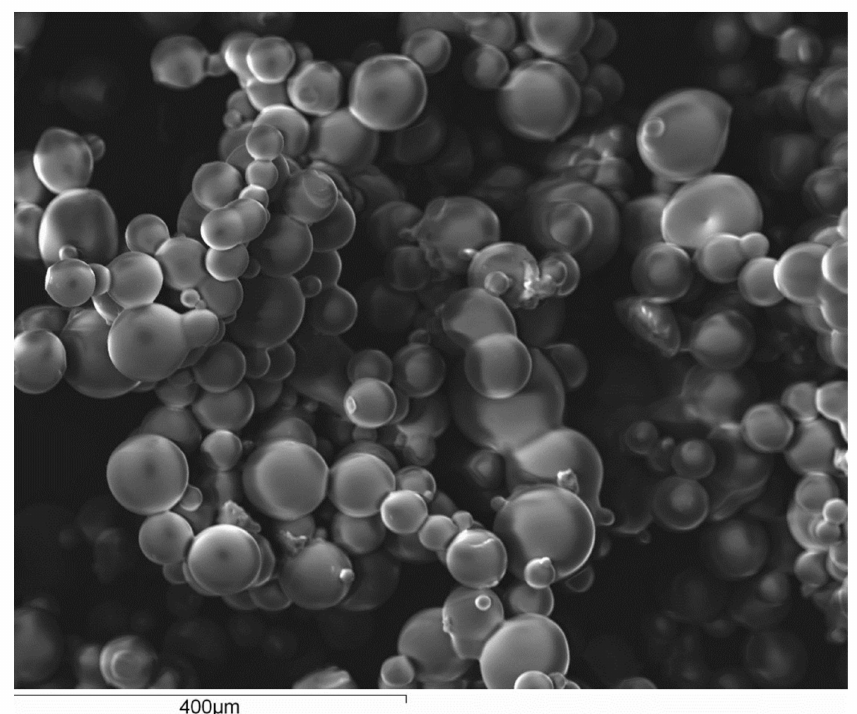
Figure A1. SEM image of PEGMA polymer resin (magnification × 150).